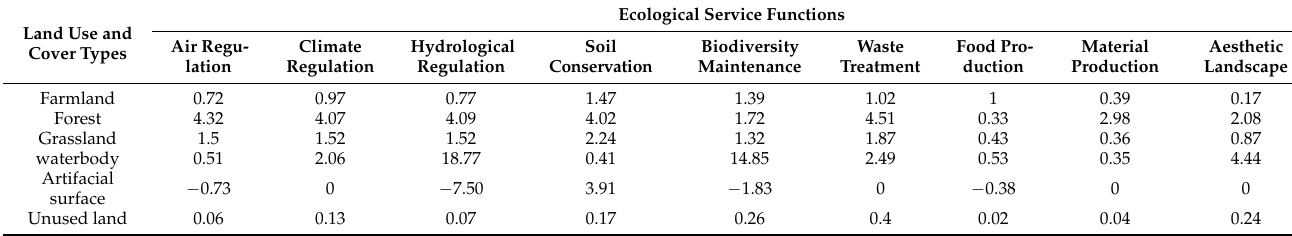
Table 2. The equivalent factors of ecological services